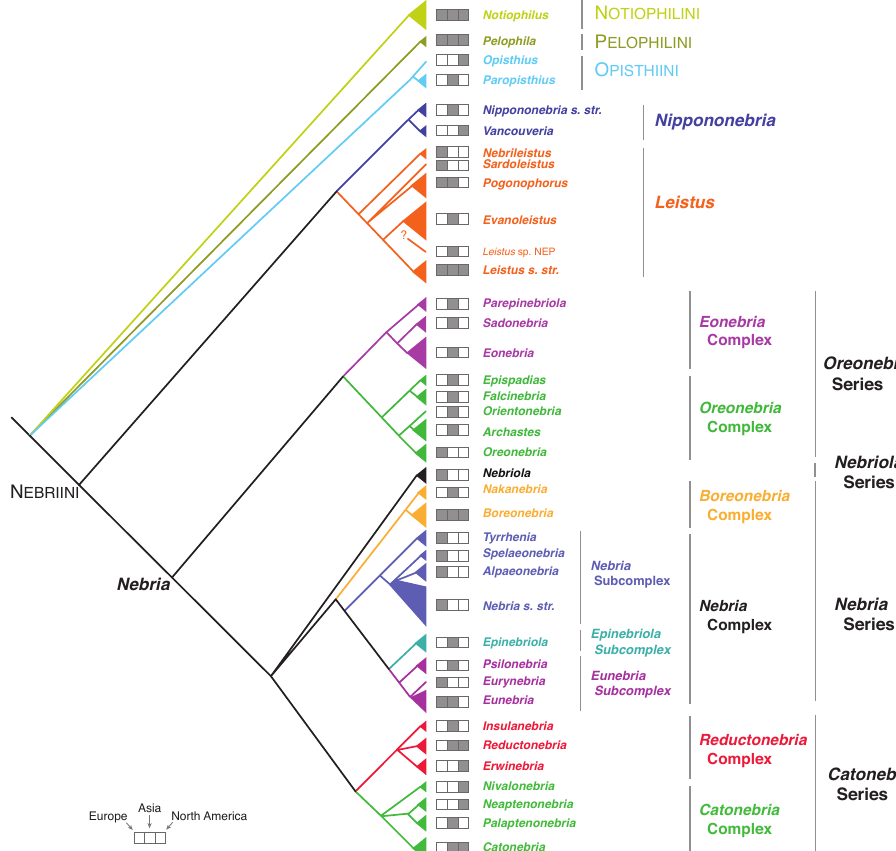
Figure 6. Summary tree of nebriite phylogeny illustrating the revised classification; clade representation in Europe (including North Africa and the Middle East), Asia, and North America is indicated in the three-box